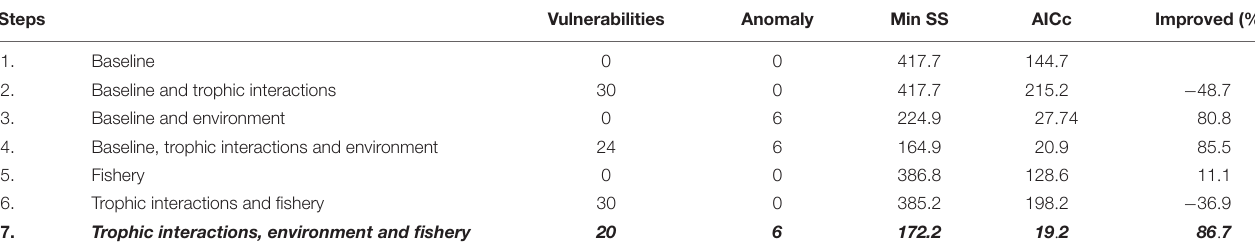
FIGURE 5 | Mixed trophic impact analysis of the Pagasitikos Gulf Ecopath model. Impact on and by the two fishing fleets is also shown (1–2). TABLE 4 | Model fits according to the seven steps applied by Mackinson et al. (2009) including trophic interactions, fishery, and environmental